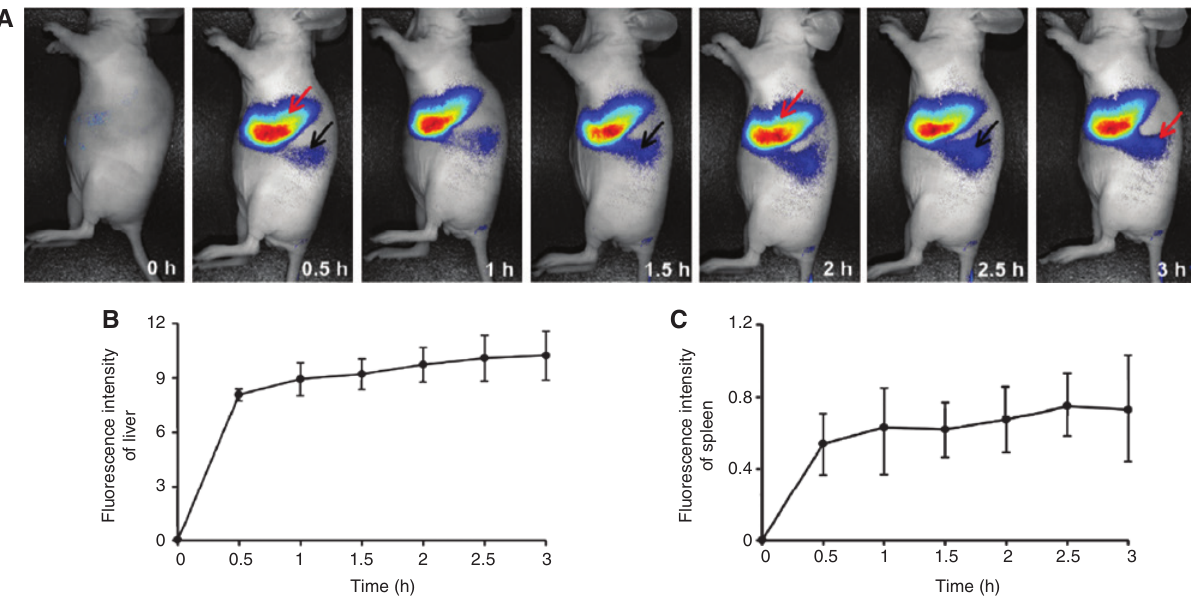
Figure 19: Fluorescence images of the biodistribution of GNS-Cy5.5 in the liver (red arrow) and the spleen (black arrow). (A) In vivo fluores- cence images of liver and spleen in mouse acquired before (0 h) and after injection (0.5, 1, 1.5, 2, 2.5, and 3 h) of GNS-Cy5.5. (B) Average light intensity of the liver time-activity curve. (D) Average signal of the spleen time-activity curve. Fluorescence signal unit: 109 photons/ cm 2 /s. Reprinted from Ref. [144]. Copyright © 2014 Optical Society of